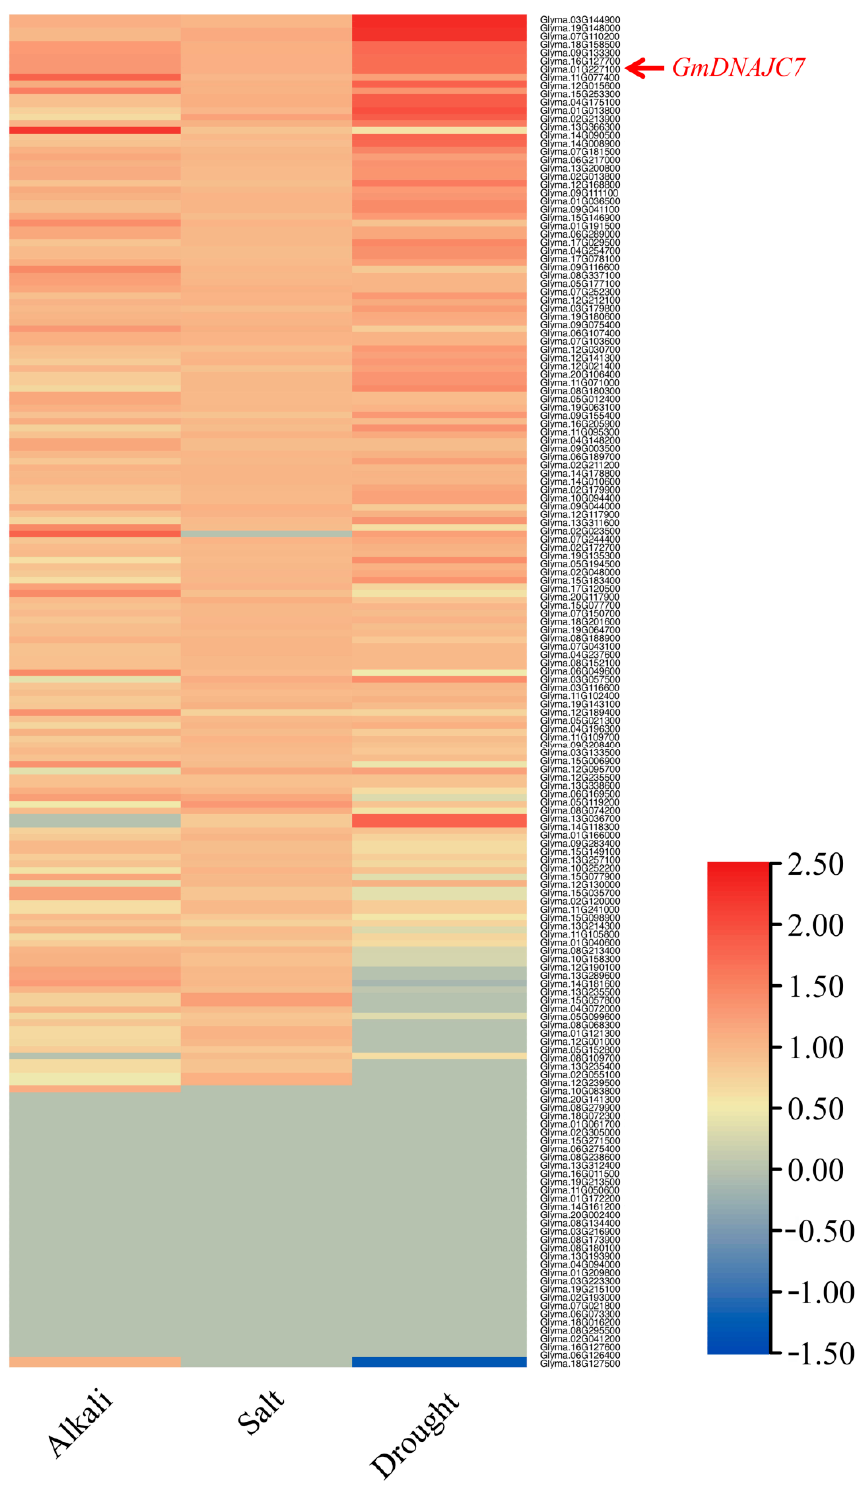
Figure 2. The heatmap of the expression profiles for the soybean DNAJ genes in response to alkali, salt, and drought stresses. The heatmap was constructed using the TBtools [34]. The DNAJ gene expression profiles in soybean under alkaline-salt, saline, and drought stresses were obtained by exploring the previously published Affymetrix GeneChip datasets: GSE17883, GSE41125, GSE50408. The color key represents the fold change (stress vs. control) scaled by row, with red to blue, indicating upregulation to downregulation.